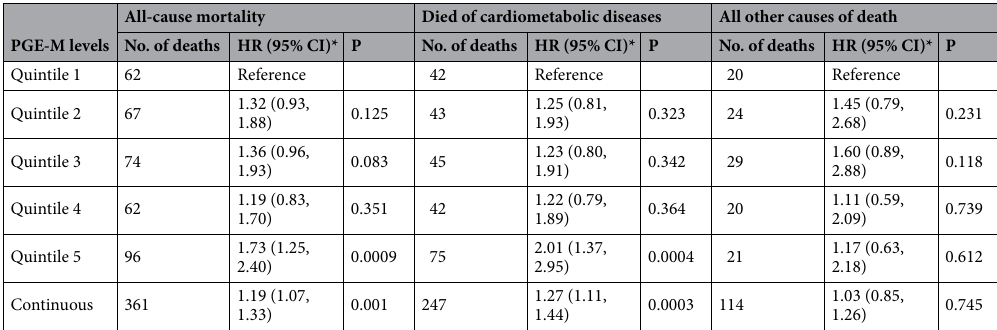
Table 2. Association between urinary PGE-M levels and death. *HRs and 95 CIs for continuous urinary PGE-M (log-transformed) were estimated for the increment by one standard deviation, with adjustment for covariates in Table 1. For cause-specific death, HRs and 95% CIs were derived from the cause-specific hazard models to account for competing risks from other causes.